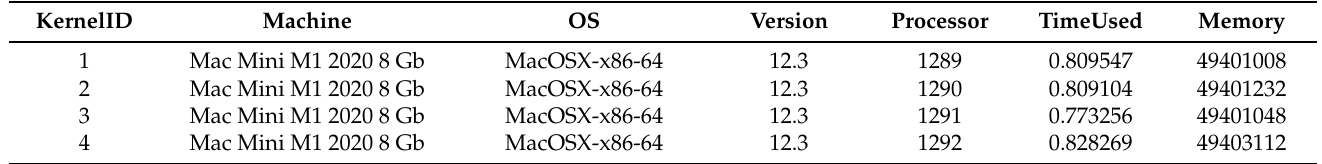
Table A2. Machine, OS and some of the 4 kernel